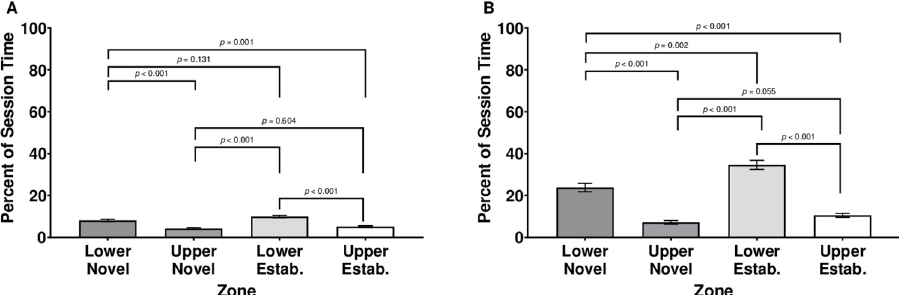
Fig 4. Percent duration in motion (A) and motionless (B) by zone across both sexes. Quadrants of the subject tank were labeled by upper/lower sections of the tank and novel/established stimulus shoal proximity. Error bars are +/- SEM . While exact p- values are reported for post-hoc comparisons, p- values smaller than 0.001 are indicated as p <